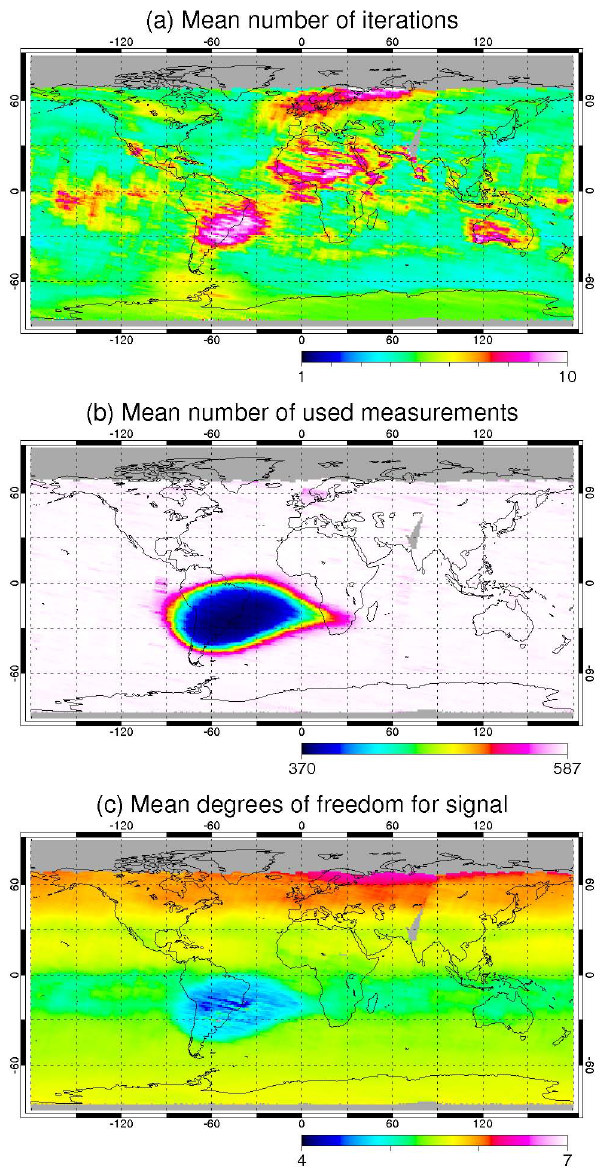
Fig. 4. Retrieval results for February 1998 with the SAA-filter ap- plied. (a) Mean iteration steps. (b) Mean number of spectral mea- surements: only measurements in the SAA are affected by the filter. (c) The reduced number of measurements, however, results in a de- crease of degrees of freedom for